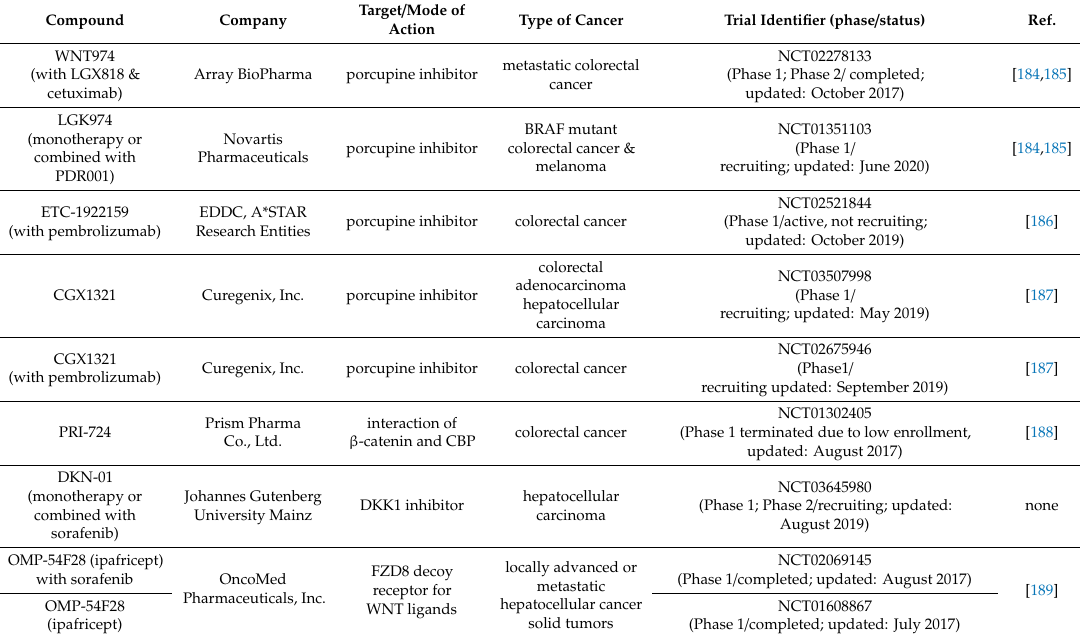
Table 3. Overview of clinical trials (current and past clinical trials) evaluating activity of drugs